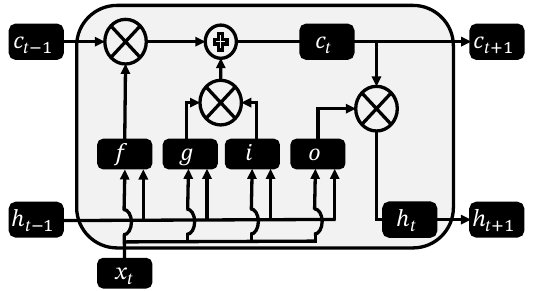
Figure 4. Graphical representation of an RNN of LSTM type. The architecture of the LSTM network used for this task, had an input layer, an LSTM Layer, a dropout Layer, a second LSTM Layer, a dropout Layer, and a final regression